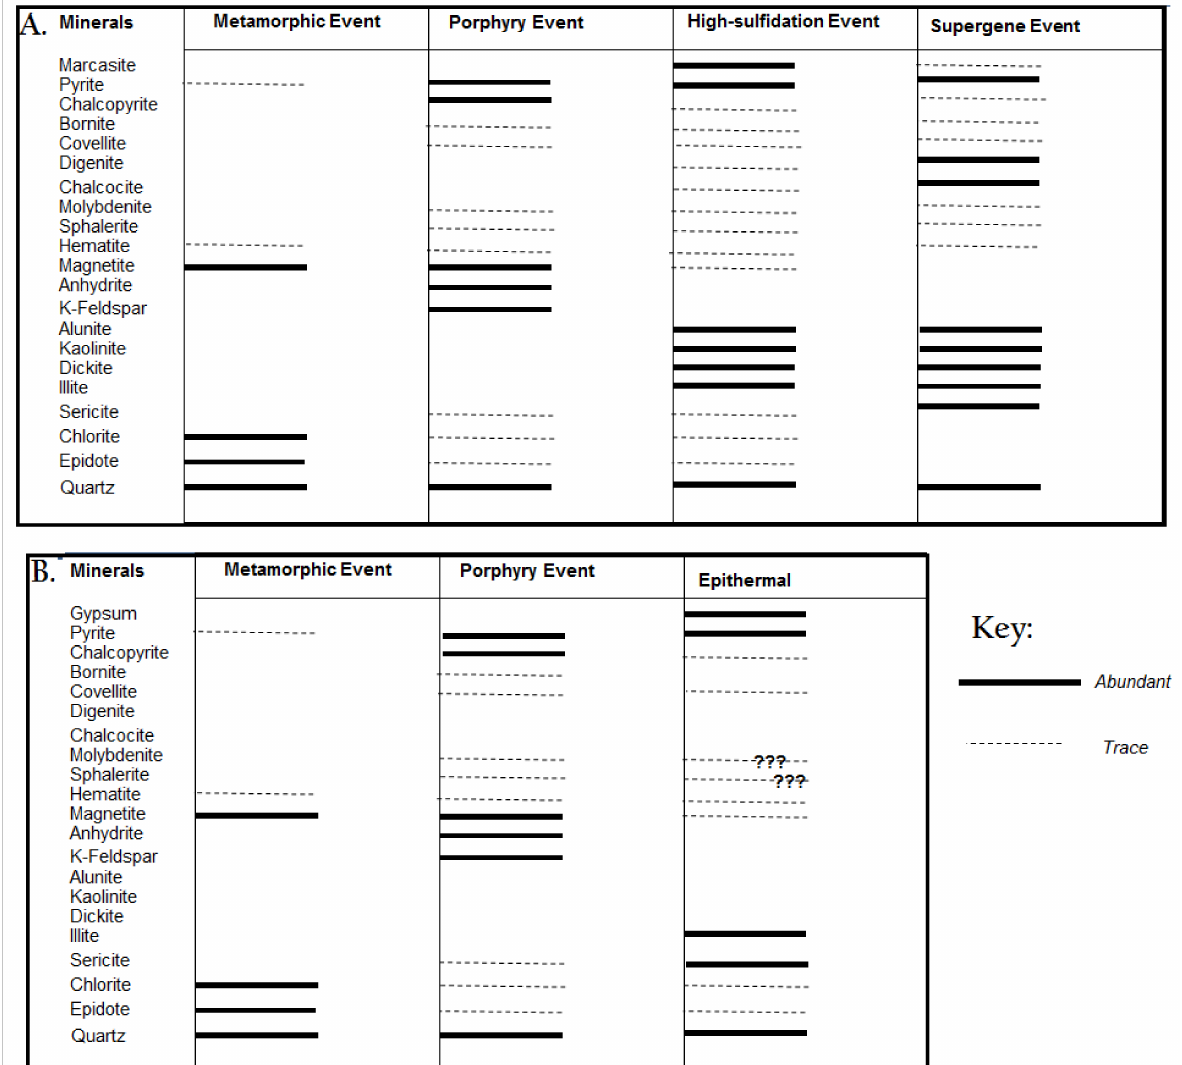
Figure 14. Interpreted paragenesis of the porphyry-related alteration and mineralization (from Lunge, 2013). ( A ) Golpu porphyry Cu-Au deposit, and ( B ) Nambonga North porphyry Cu–Au